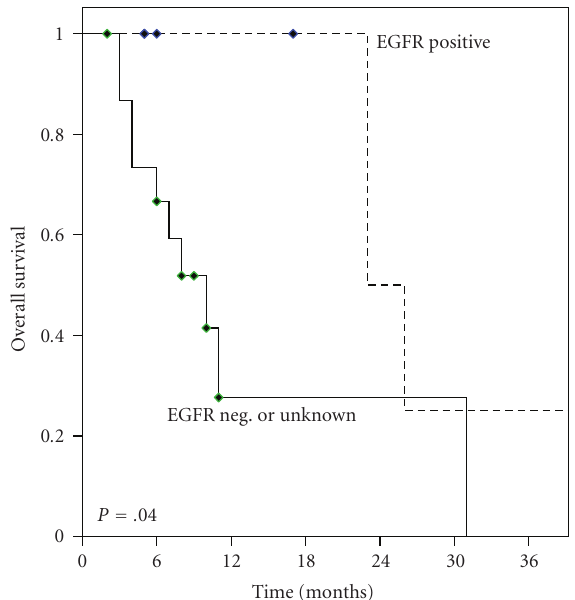
Figure 4: Overall survival in relation to the status of EGFR gene activating mutations